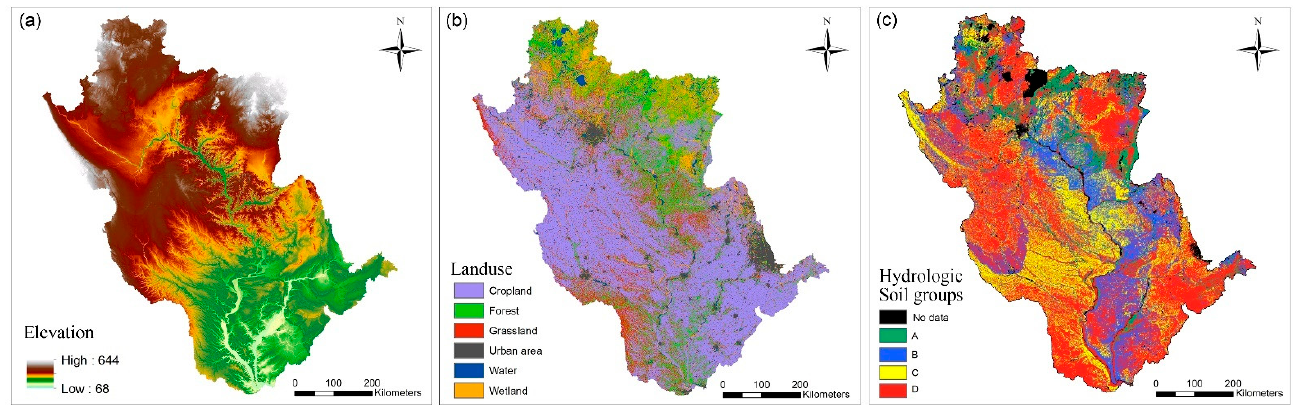
Figure 2. Upper Mississippi River Basin (UMRB) maps showing ( a ) elevation, ( b ) land use types and ( c ) hydrologic soil groups.